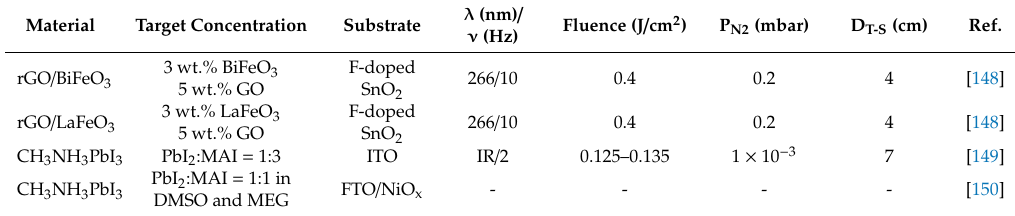
Table 7. Perovskites prepared by